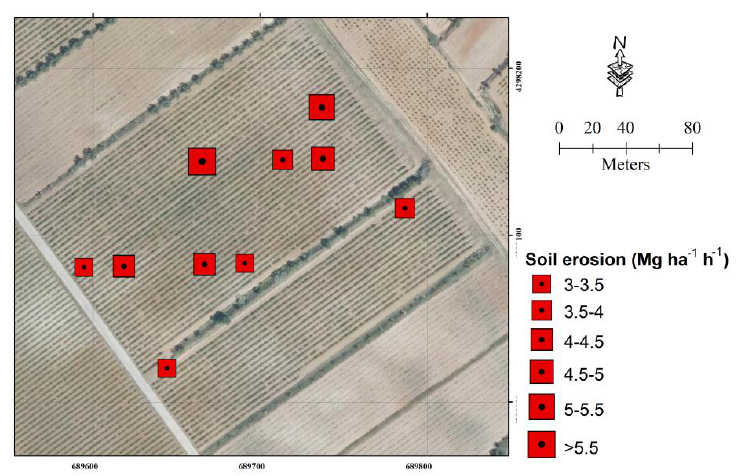
Figure 5. Spatial distribution of sediment concentration. Beverages 2018 , 4 , 31